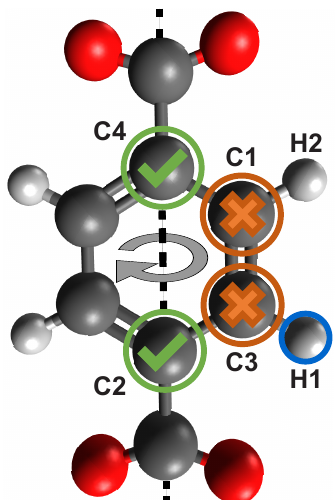
Figure 15. To identify a candidate all hydrogen atoms are first collected. Every hydrogen not connected to a carbon atom is disregarded. The screening algorithm then checks if the carbon atom is part of an aromatic ring structure and if a rotation axis exists by checking its neighbors in each direction. If a carbon atom is found that is connected to another three carbon atoms in each direction, the algorithm marks the hydrogen as a positive